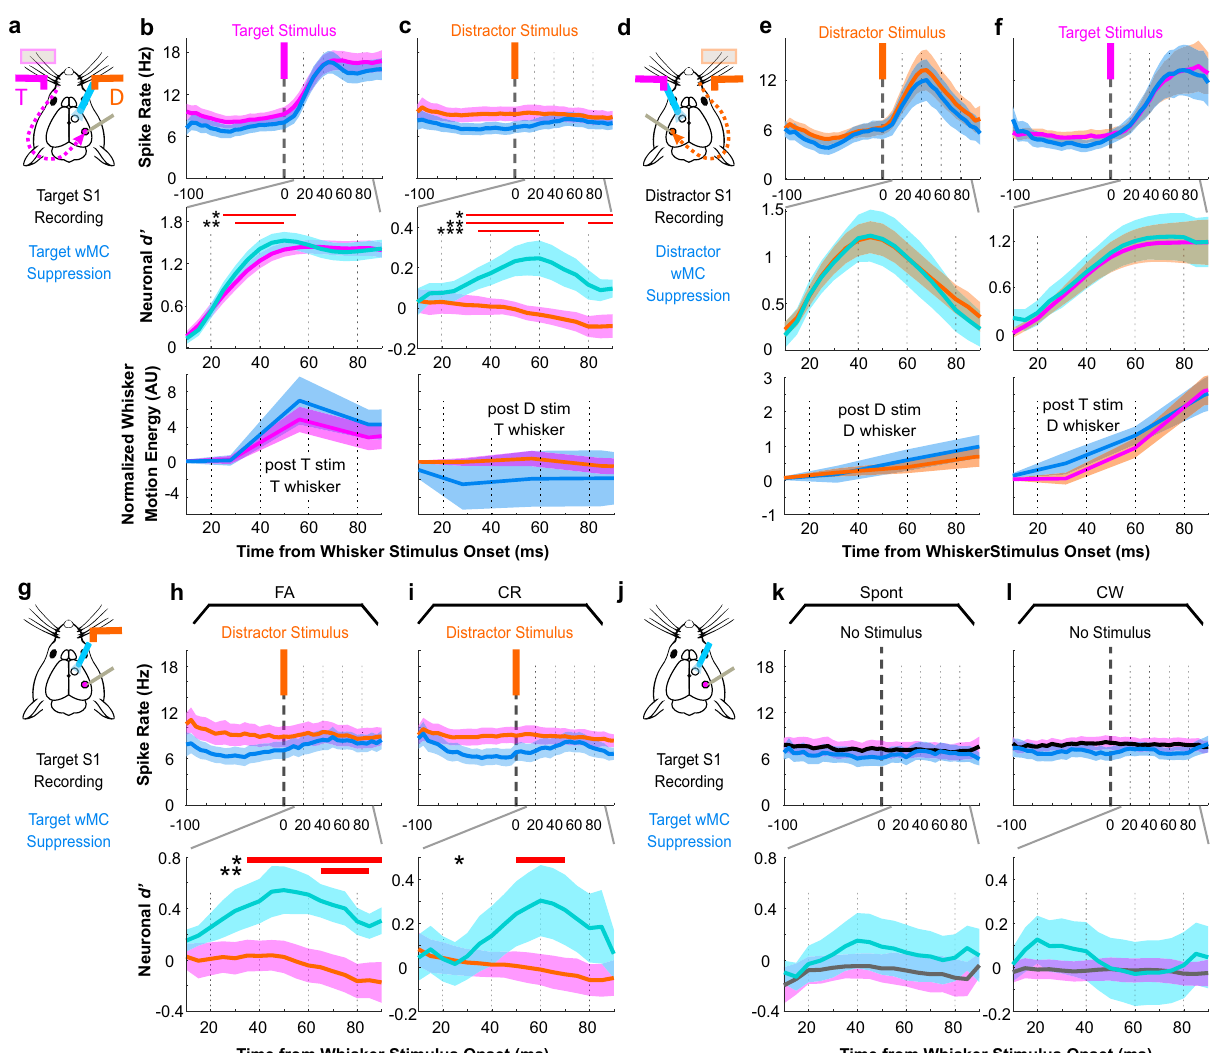
Fig. 3 | Suppressing wMC increases distractor stimulus encoding in target- aligned S1. Analyses of neuronal recordings in expert mice during task per- formance. For magenta/orange traces, the solid line re fl ects the stimulus identity(target,magenta;distractor,orange)whereastheSEMshadingre fl ects the recording site (target-aligned S1 or target fi eld whiskers, magenta; distractor-aligned S1 or distractor fi eld whisker, orange), as in Fig. 2. a Experi- mental design illustration for [ b , c ]: recording in target-aligned S1 or target whisker fi elds, suppression of target-aligned wMC, target stimulus is preferred and distractor stimulus is unpreferred. b , c Neuronal spike rate (top) and neuronal d ’ (middle) of target-aligned S1 neurons, and whisker motion energy within the target whisker fi eld (bottom) during control trials (light-off, magenta) and wMC suppression trials (light-on, blue) in response to target [ b ] or distractor [c] whisker stimuli. Data are grand averages, combined from all recording sessions. The red bars indicate the epochs in which neuronal d ’